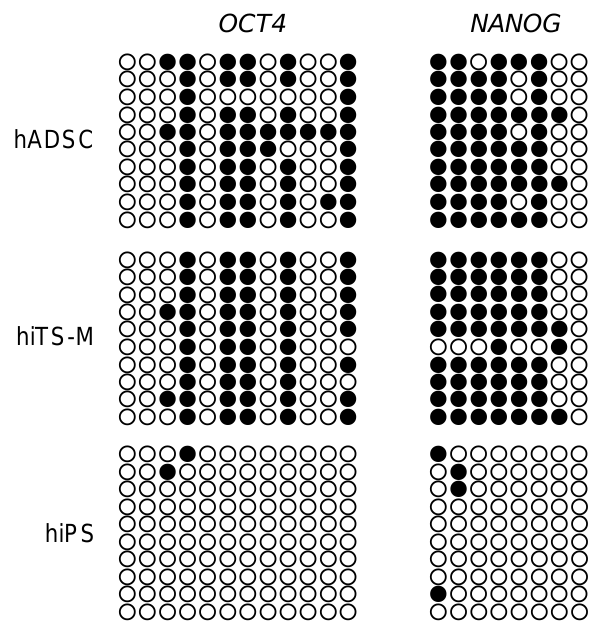
Figure 5. Bisulfite genomic sequencing of promoter regions of OCT4 and NANOG in hADSCs, hiTS-M cells, and hiPS cells. Open circles indicate unmethylated CpG dinucleotides, whereas closed circles indicate methylated CpGs.